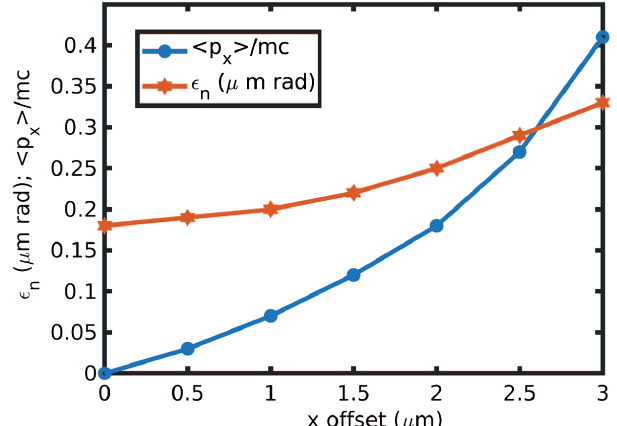
FIG. 10. Transverse jitter analysis. AL a D yn 2D slab simulations with varying transverse offset from the ionizing pulse (on axis) and the driving train. The x represents the distance of the train offset center-of-mass from the simulation axis. The center-of-mass transverse momentum (orange) and the normalized emittance (blue) dependence on x are offset